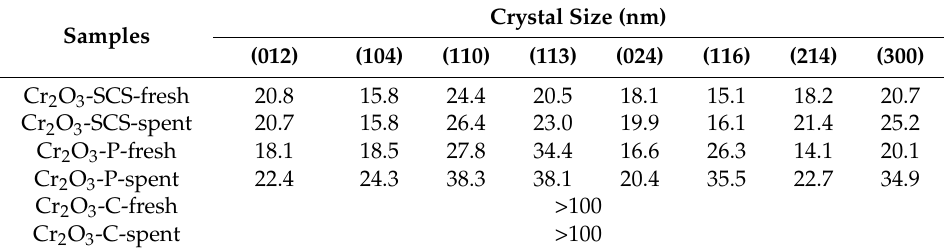
Table 1. Crystal size changes of fresh and spent Cr 2 O 3 catalyst prepared by different methods.